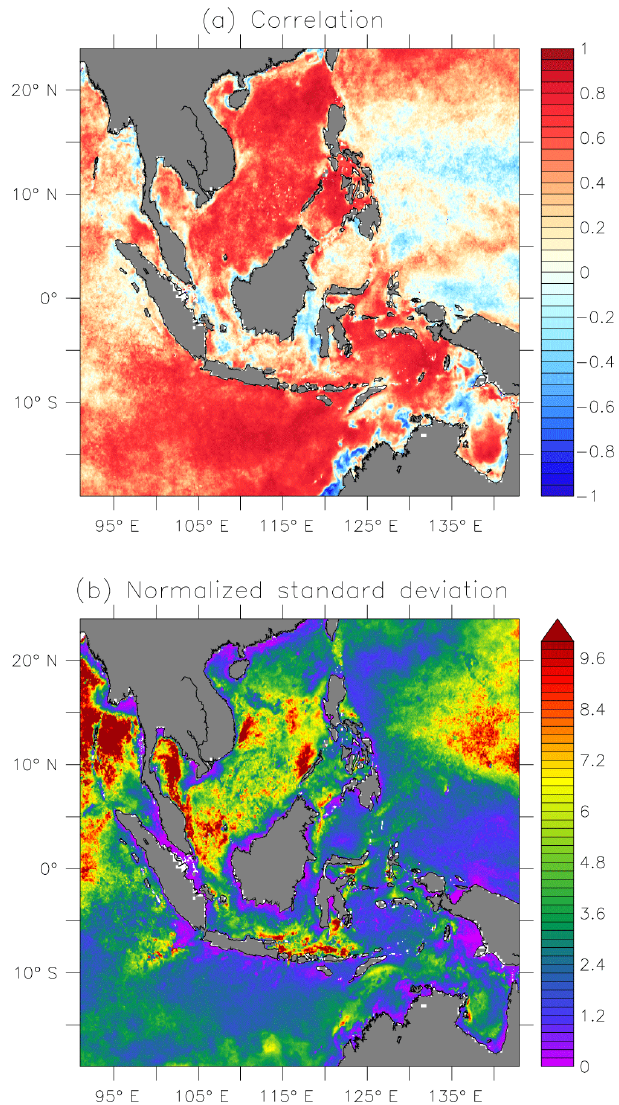
Figure 11. Temporal correlation (a) and normalised standard devia- tion ( b ; SD(model) / SD(data)) estimated between the INDO12BIO simulation and the MODIS case-1 ocean colour product. Statistics are computed on monthly fields between 2010 and 2014. The model was masked as a function of the